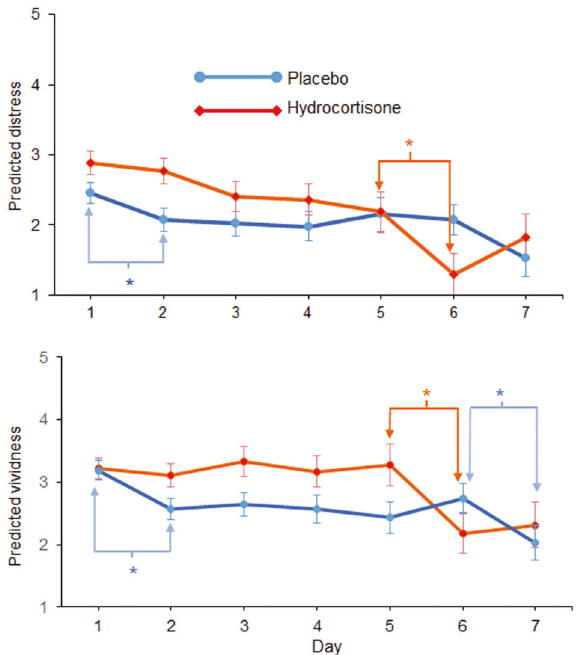
vividness (bottom) ratings for placebo (blue lines) and hydrocorti- sone (red lines) * p <